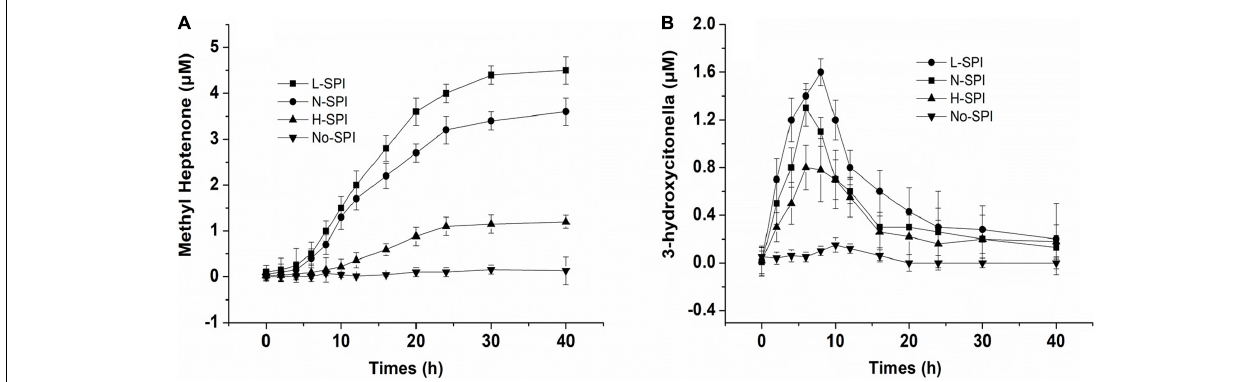
FIGURE 3 | Effect of different treated protein on the SPI—catalyzed to citral (A,B) , the concentration of protein is 1% (w/v), 20 mmol/L potassium phosphate buffer, citral’s primary concentration is 24 µ mol/L.